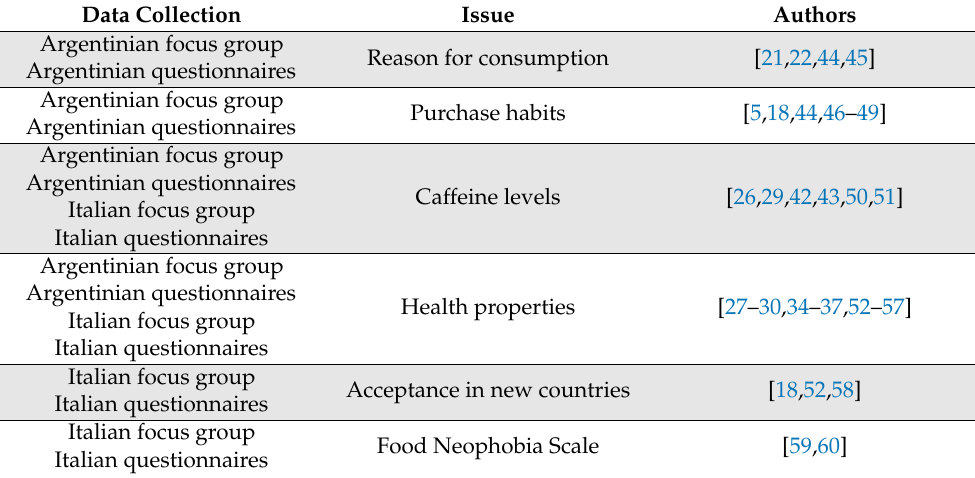
Figure 4. Mate caffeine content. Table 1. Literature references of data collection